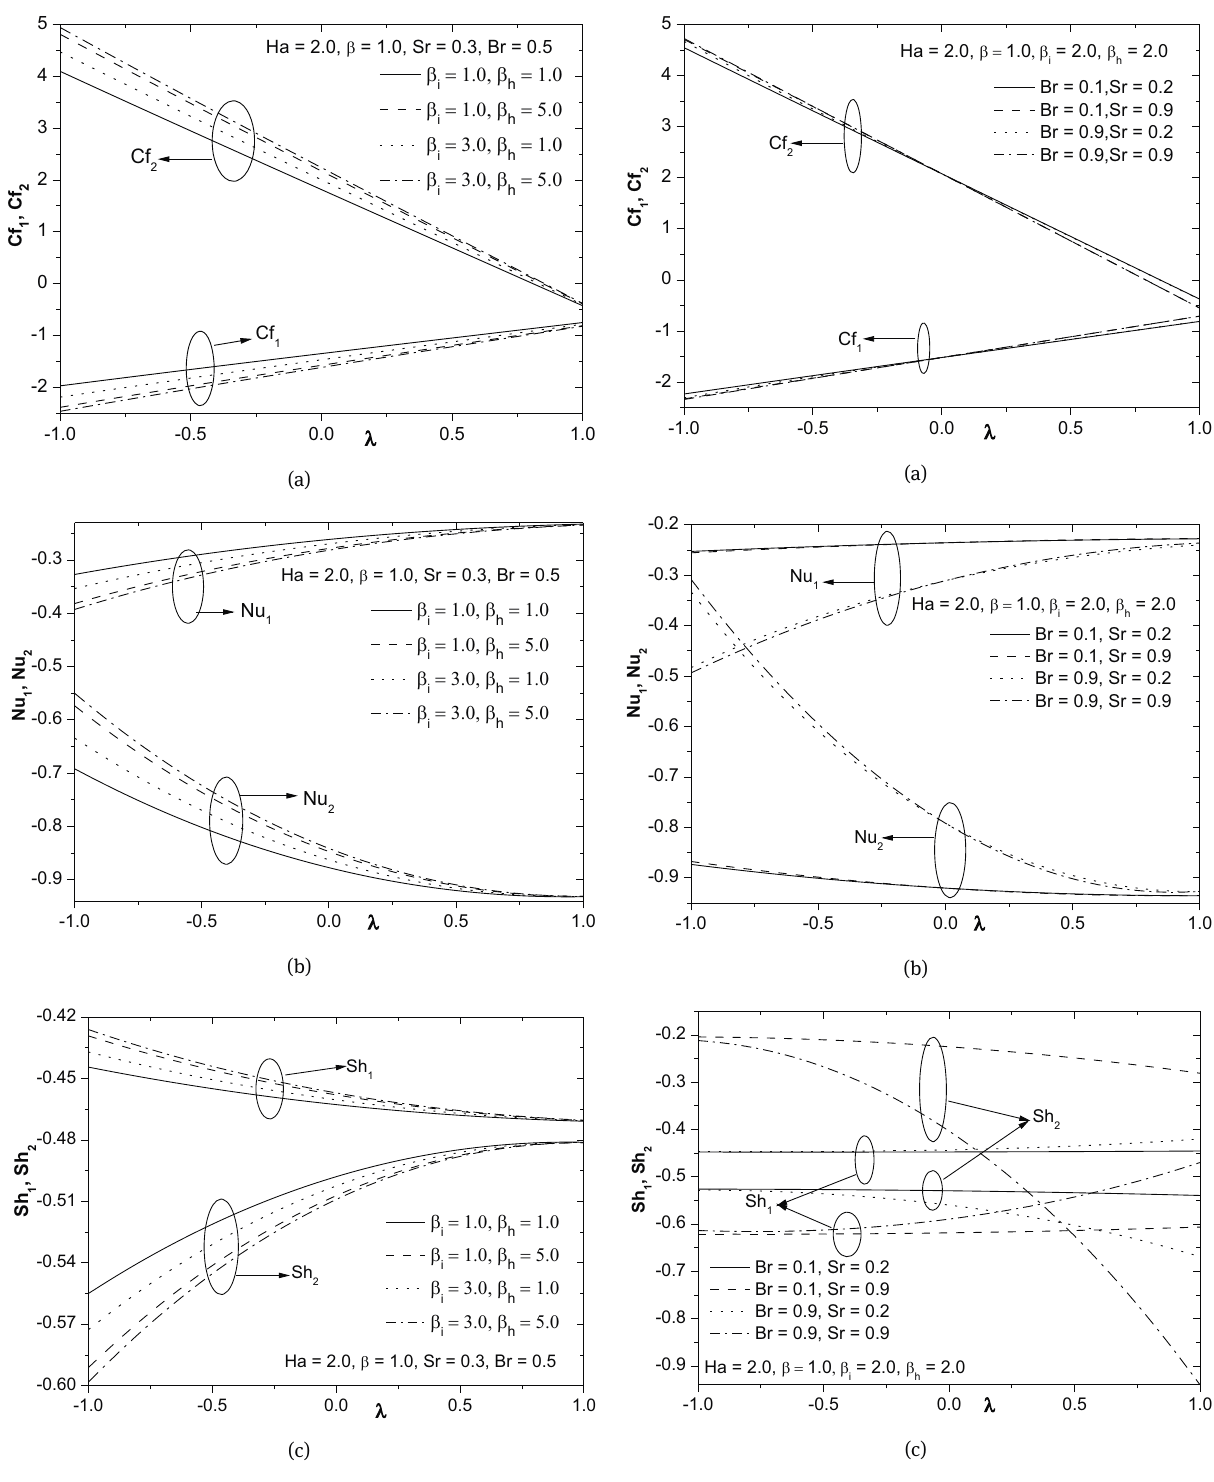
Fig. 5: Effect of β i and β h on (a)skin friction, (b)heat transfer rate, (c)mass transfer rate profiles at both the walls of the channel